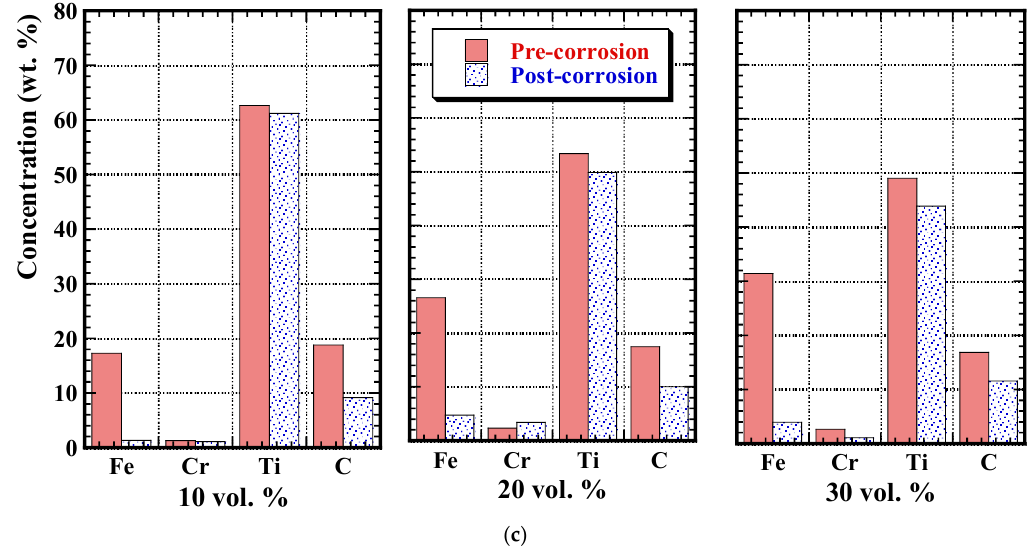
Figure 11. Comparative energy dispersive X-ray spectroscopy (EDS) elemental analyses of the surface of TiC–stainless steel samples prepared with 10 vol. % to 30 vol. % steel binder, both before and after corrosion testing: ( a ) TiC-304 L; ( b ) TiC-316 L; and ( c ) TiC-410 L. Note that the balance for each material, adjusted to 100 wt. %, is comprised of O. The presented EDS data is the average of three to five analyses for each material.